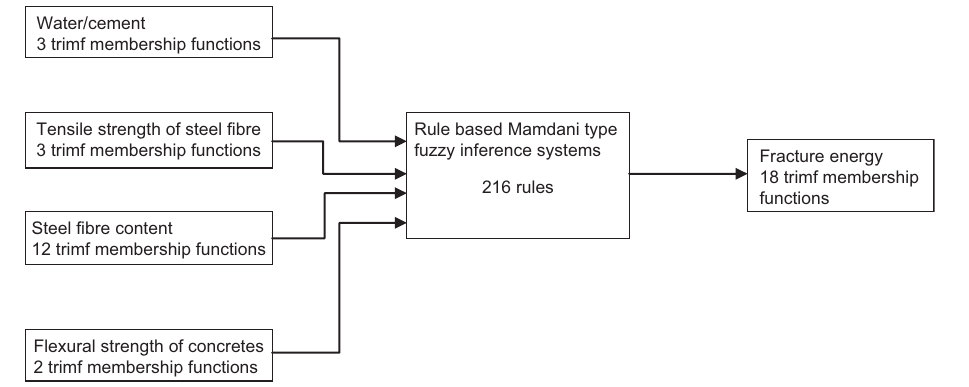
Figure 9 General structure of the